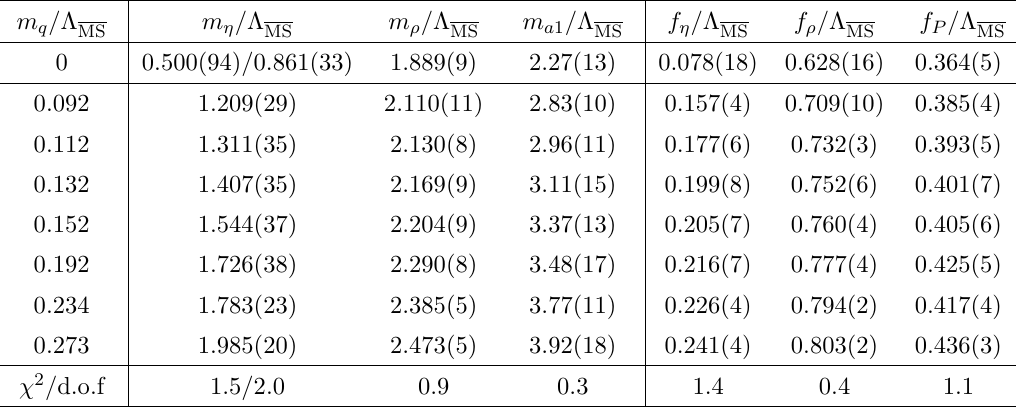
Table 2 . Numerical values for some masses and decay constants from our lightest quark simulations. Values at zero quark mass are obtained from various extrapolations as explained in the text.